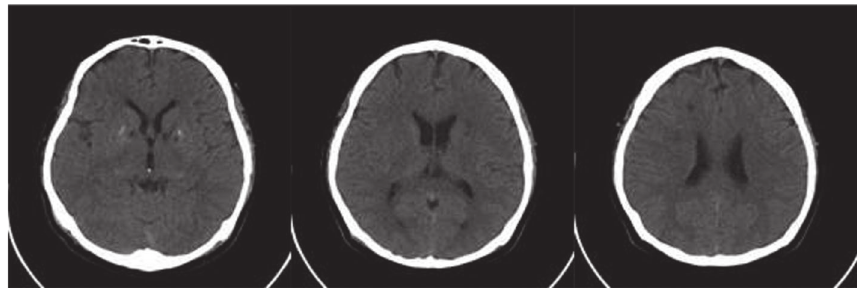
Figure 1: Multiple lacunar hypodense lesions on the CT